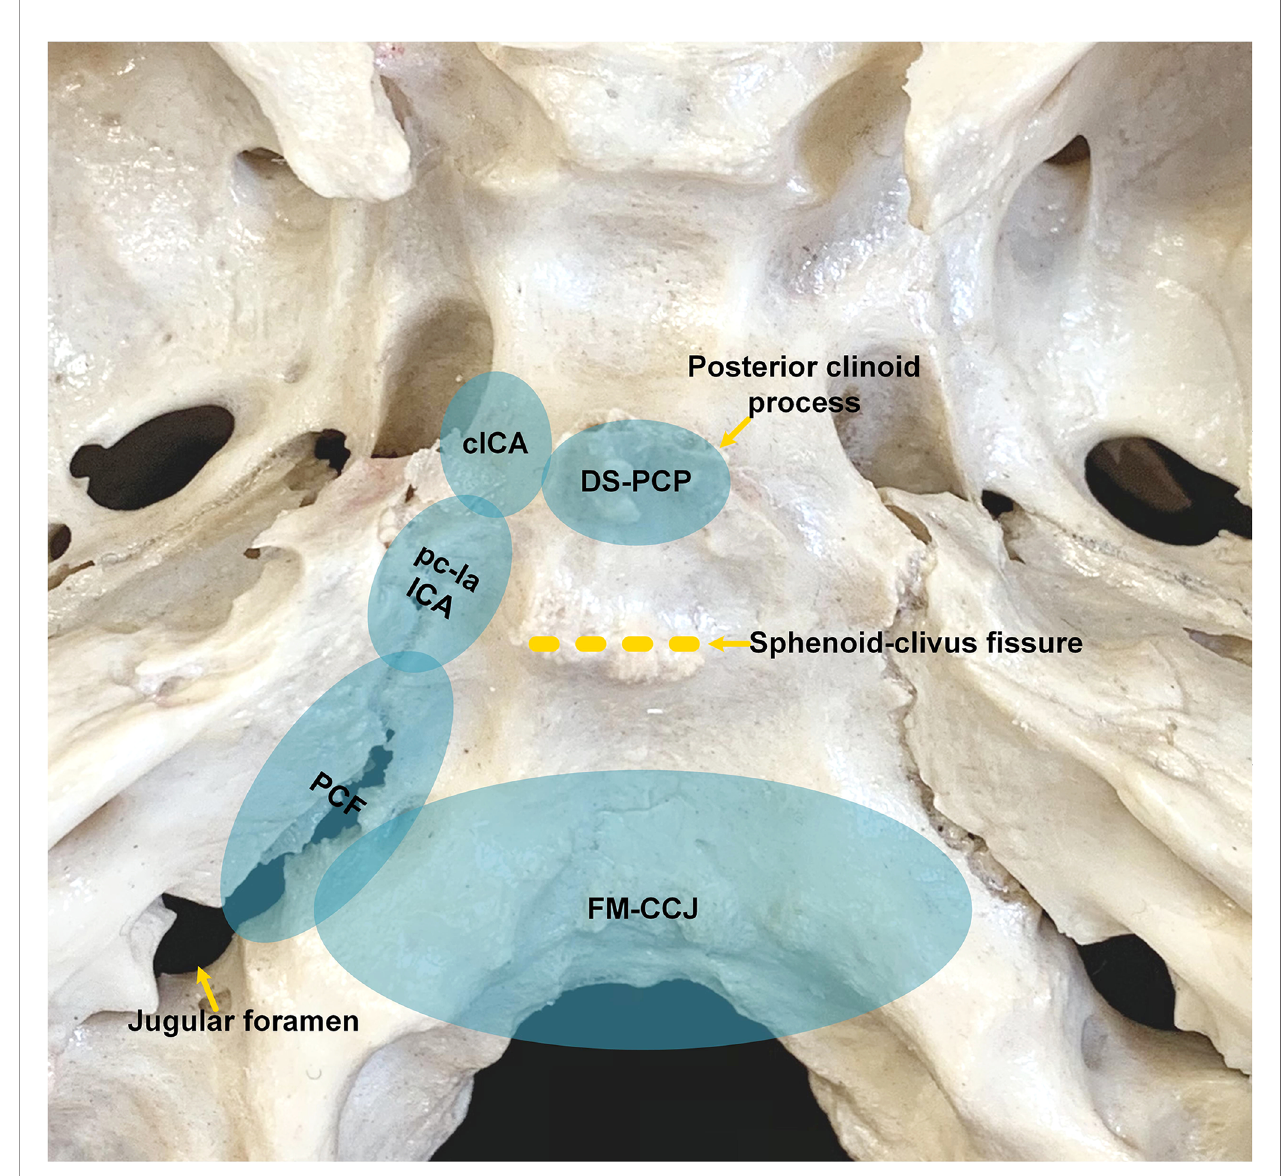
FIGURE 1 | Anatomic spaces that skull base chordomas frequently invade. cICA, cavernous internal carotid artery; DS-PCP, dorsum sellae and posterior clinoid process; FM-CCJ, foramen magnum and craniocervical junction; PCF, petroclival fi ssure; pc-la ICA, paraclival and lacerum